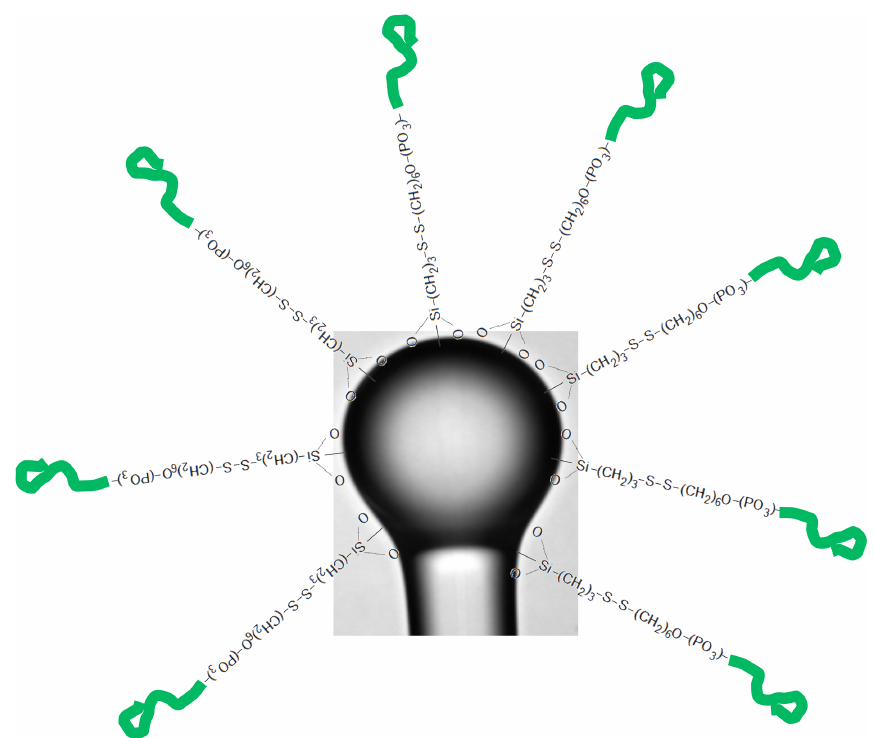
Figure 8. Functionalization of a WGMR for an aptasensor: after activation of the surface with piranha solution, silanization with 3-mercaptopropyltrimethoxysilane (MPTMS); and thiol bonding to the thrombin